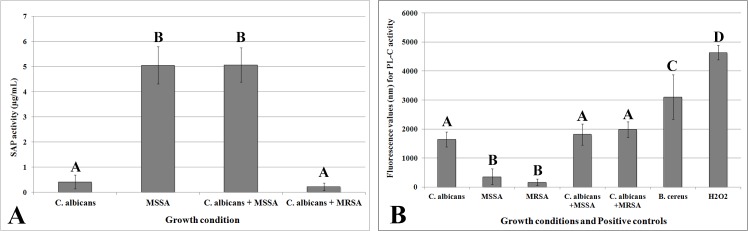
SAP (A) and PL-C (B) activities of biofilms of C. albicans, MSSA, and MRSA, as single- and dual-species grown in RPMI at 37°C, and the positive controls.Error bars represent standard deviation. The uppercase letters show differences among the growth conditions (Games-Howell post-hoc test at ρ>0.05).